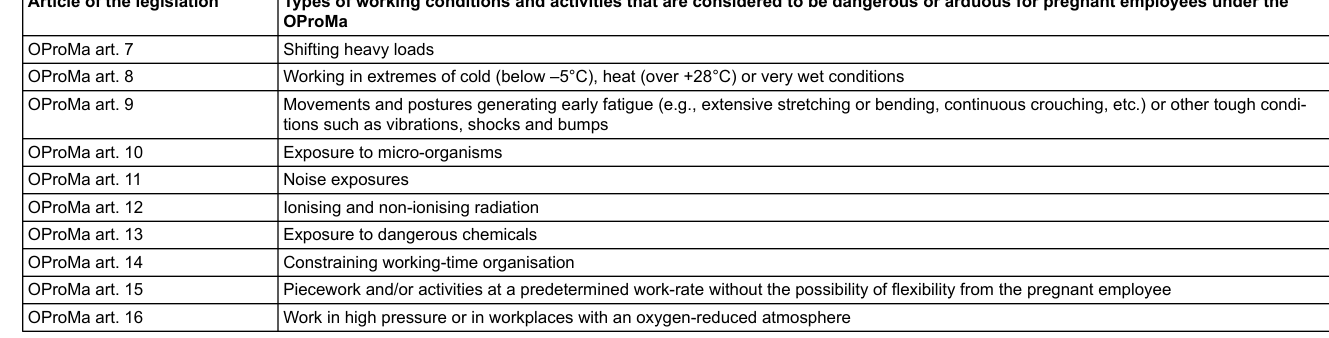
Table 1: Dangerous or arduous activities as detailed in the OProMa